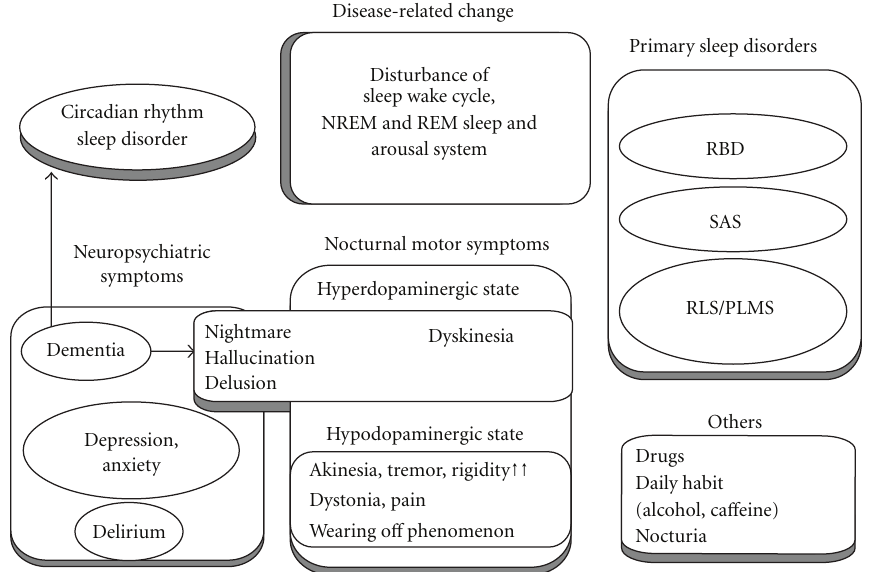
Figure 1: The major causes of insomnia and its contributing factors. RBD: rapid eye movement sleep behavior disorder; SAS: sleep apnea syndrome; RLS: restless legs syndrome; PLMS: periodic limb movement during sleep. symptoms such as nocturia, nocturnal cramps, dystonia, and tremors were observed in untreated PD patients with short disease durations. PDSS-2, a new version of PDSS, has been developed, and its total and three domain scores, including disturbed sleep, motor symptoms at night, and PD symptoms at night, have been shown to correlate with patients’ quality of life, the Unified Parkinson’s Disease Rating Scale (UPDRS) motor scores, and disease severity in di ff erent patterns